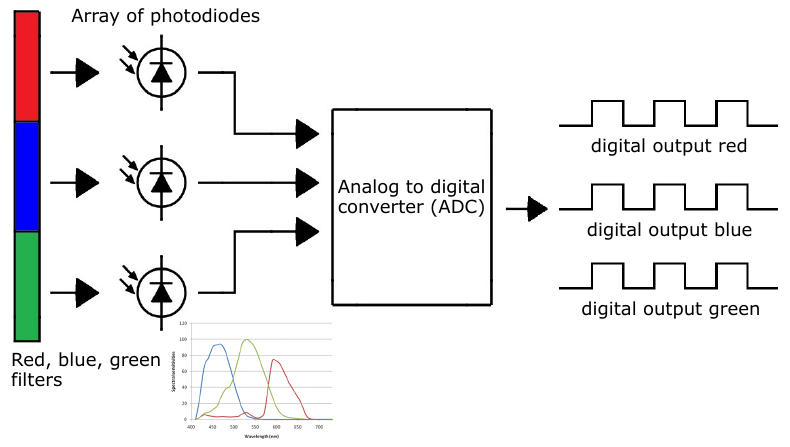
Figure 1. Physical and electronic principle of an RGB color